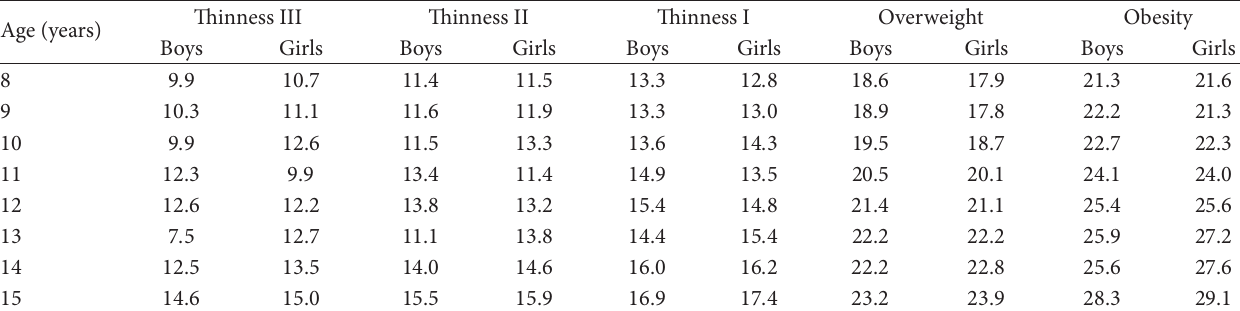
Table 4: Age- and gender-specific BMI cutoffs for the classification of nutritional status, obtained by using LMS method applied to our Cameroon